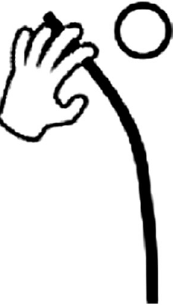
FIG. 1. Top view of ring slider scenario, in which a metal ring is smacked by a bent-back ruler and slides across the